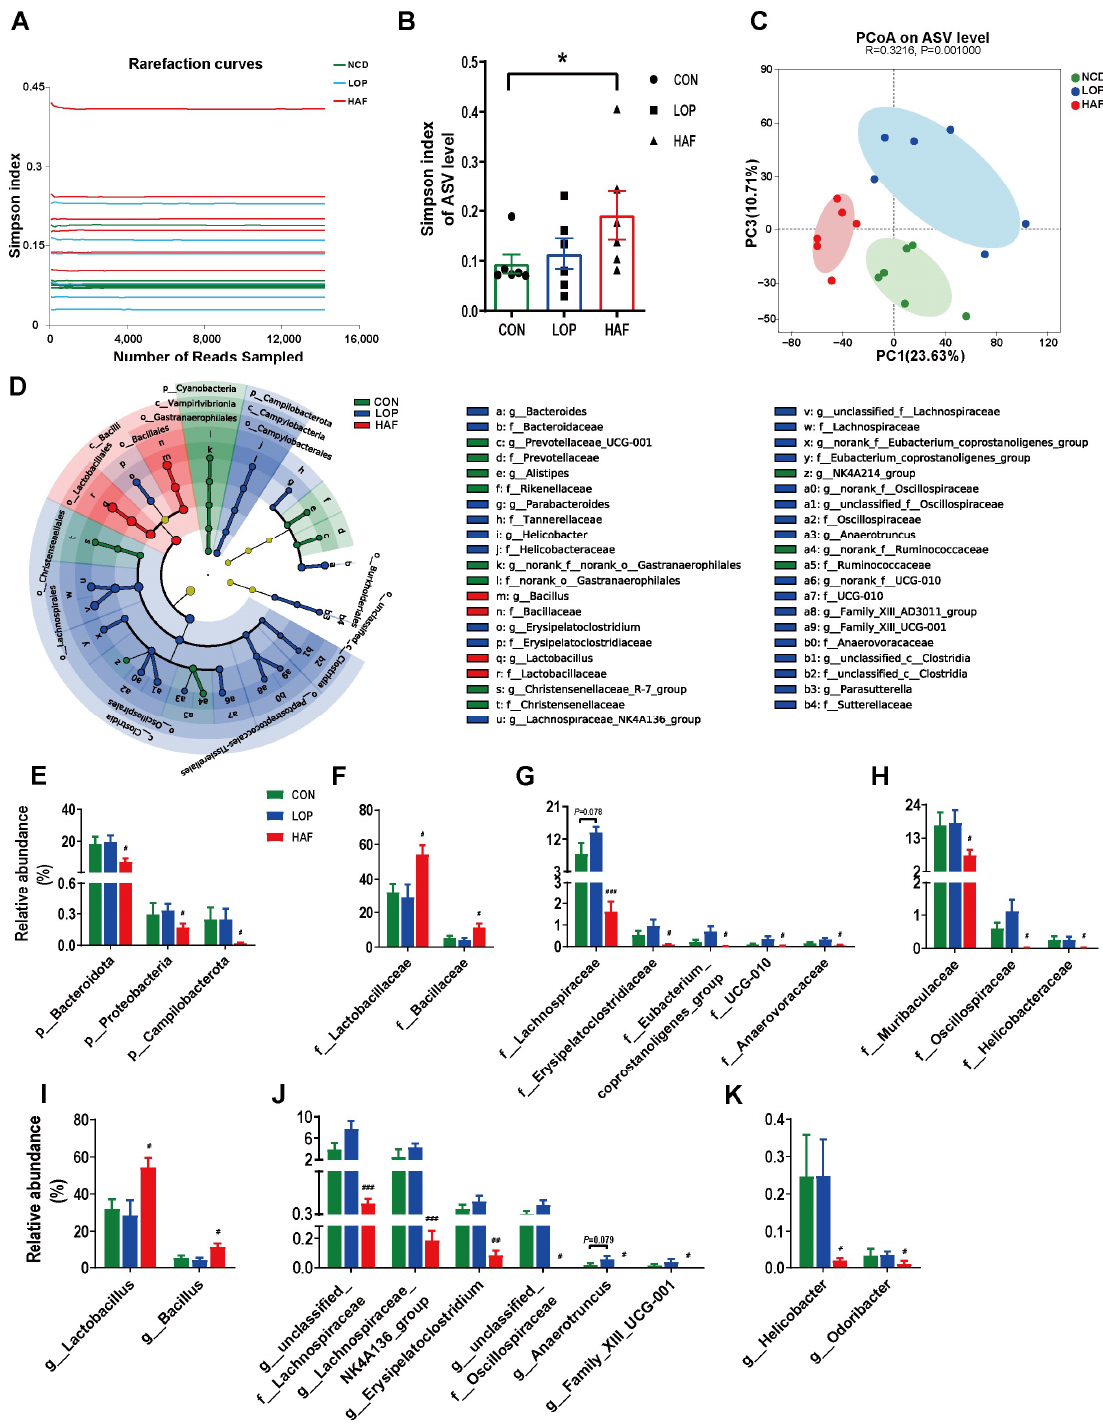
Figure 3. HAF restores the loperamide-induced gut microbial community structural and composi- tional shift. ( A ) The rarefaction curve of the Simpson index of each sample plateau at the ASV level. ( B ) Alpha diversity estimated by the Simpson index. ( C ) PCoA (principal coordinate analysis) plot based on binary Euclidean distance. ( D ) Linear discriminant analysis effect size (LEfSe) analyses (LDA score > 2.0). ( E – K ) Relative abundances of gut microbiota at the phylum, family, and genus levels, which were significantly affected by LOP or HAF, especially those reversed by HAF treatment. The data are expressed as the means ± SEMs ( n = 6). *, compared with the CON group; #, ##, ###, compared with the LOP group. *, p < 0.05; #, p <0.05; ##, p < 0.01; ###, p <